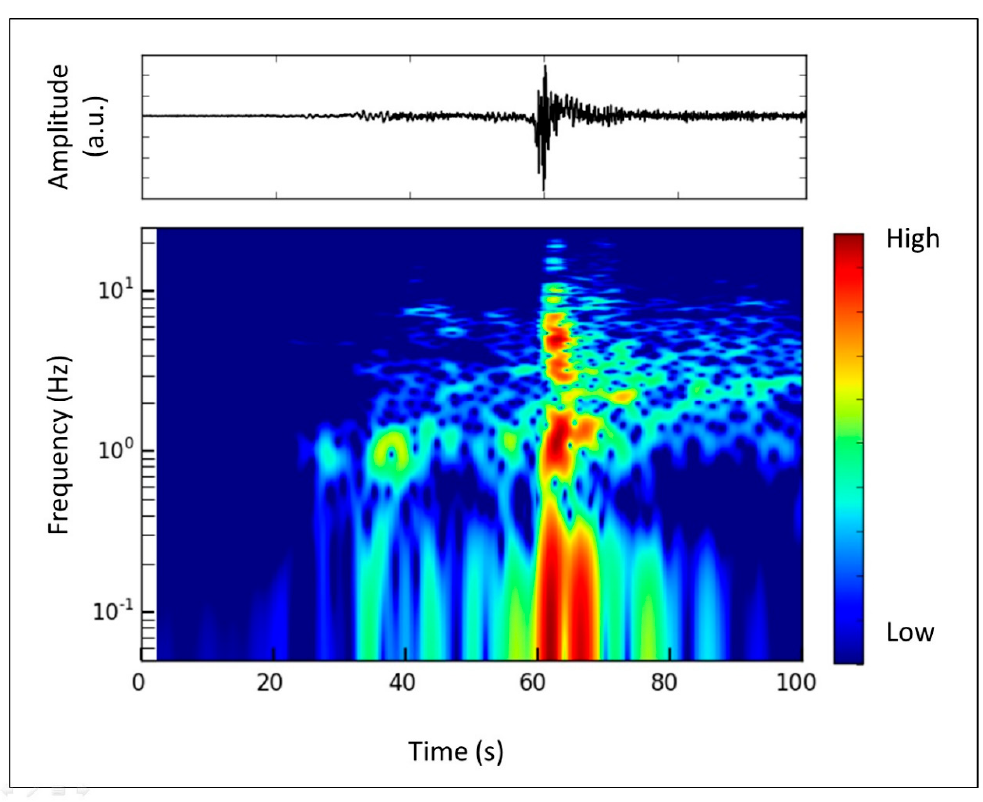
Figure 8. Seismogram (above) and spectrogram (below) of the 1 December 2017 major explosion (STRA vertical component).